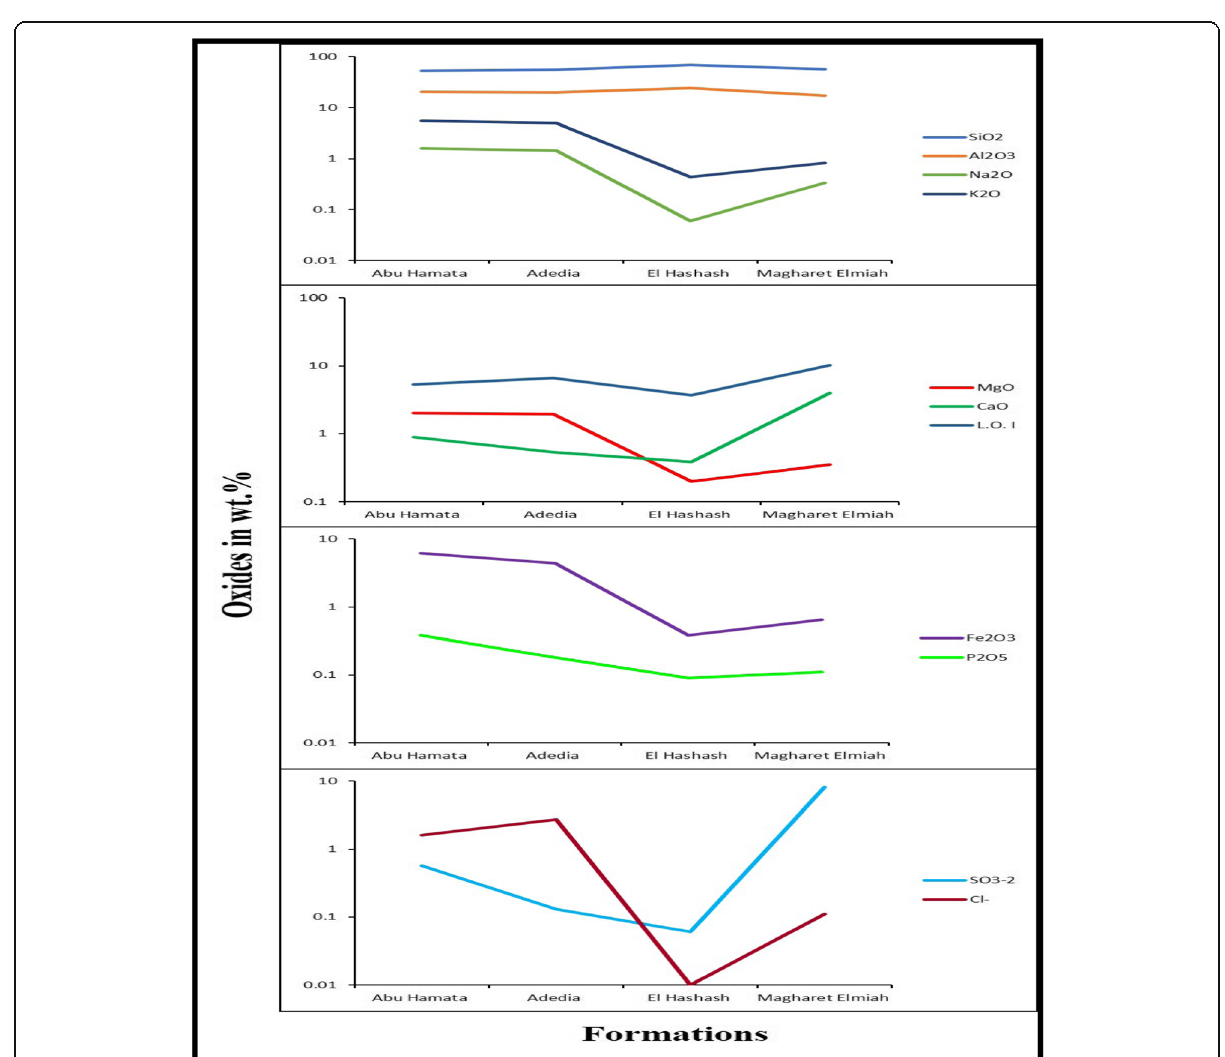
Fig. 6 Averages distribution curves of the studied mudrocks major chemical